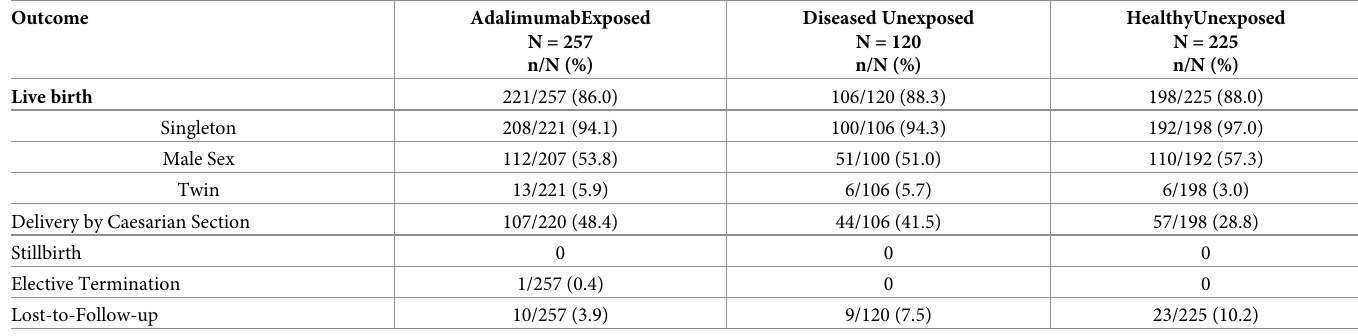
nasal bridge, a sacral dimple, and bilateral incurving of the 5 th fingers. One of these four chil- dren also had multiple major structural birth defects including asymmetry of the brain ventri- cles, bicuspid aortic valve, and congenital chordee. Neither of the same two clusters were identified in the comparison groups (Table 3). The adjusted HR for spontaneous abortion in the adalimumab-exposed cohort compared to the diseased unexposed cohort was 2.22 (95% CI 0.67 to 7.29). The adjusted HR was some- what higher in comparison to the healthy cohort, but with wide confidence intervals (adjusted HR 4.27, 95% CI 0.96 to 18.95). The adjusted HR for preterm birth was 0.82 (95% CI 0.66 to 7.20) in adalimumab-exposed pregnancies compared to the diseased unexposed group. How- ever, in comparison to the healthy group, the adjusted HR for preterm delivery was elevated (2.59, 95% CI 1.22 to 5.50) (Table 4). Infants � 10 th centile at birth or at approximately one year of age on weight, length and head circumference did not differ significantly in any between-group comparisons (Table 5). Serious or opportunistic infections in the first year of life were infrequent, occurring in 20/ 543 (3.7%) of live born infants. There were no significant differences between the adalimu- mab-exposed group compared to the diseased unexposed group (unadjusted RR 0.97, 95% CI Table 2. Pregnancy outcomes of women exposed to adalimumab compared to women not exposed,